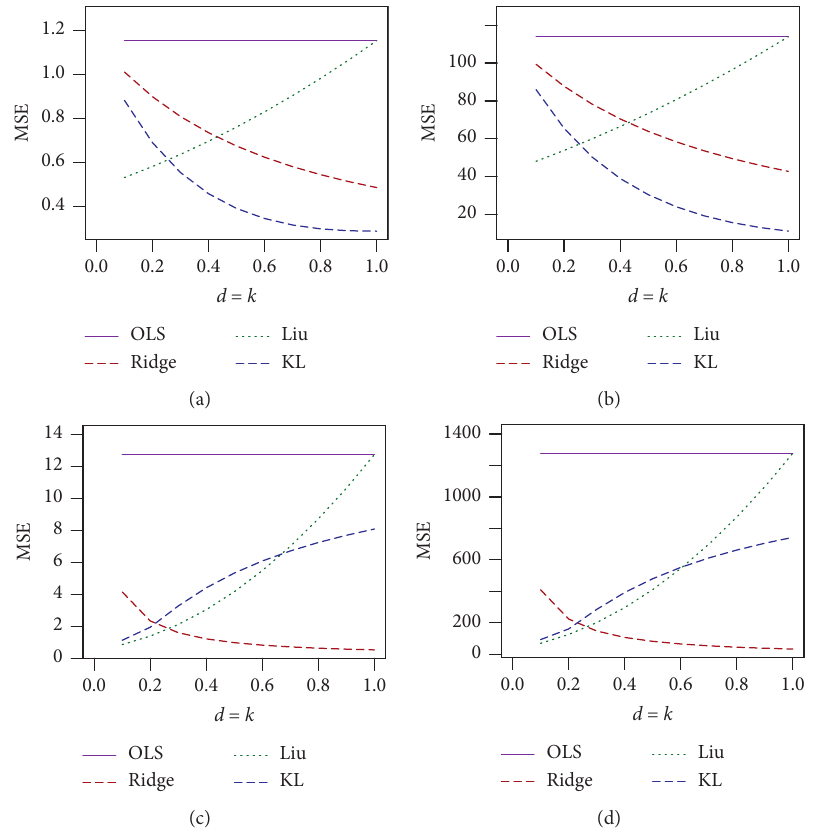
Figure 2: Estimated MSEs for n � 30, sigma � 1, 10, rho � 0.90, 0.99, and different values of k � d . (a) n � 30, p � 3, sigma � 1, and rho � 0.90. (b) n � 30, p � 3, sigma � 10, and rho � 0.90. (c) n � 30, p � 3, sigma � 1, and rho � 0.99. (d) n � 30, p � 3, sigma � 10, and rho �